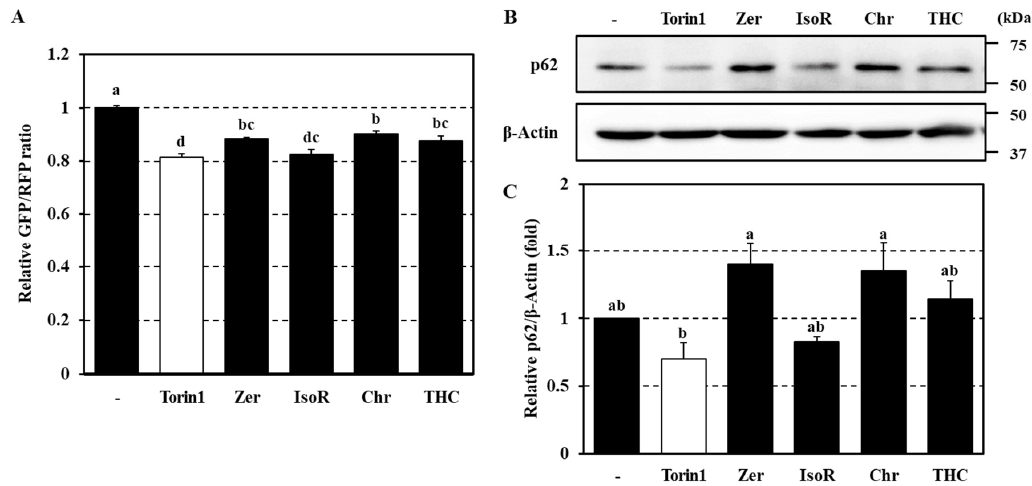
Figure 5. Effects of active phytochemicals on p62 protein expressions in Caco-2 cells. Caco-2 cells were treated with Torin1 (1 µM) or each flavonoid (20 µM) for 4 h. To determine the autophagy flux, intracellular fluorescence intensities were measured using a Cellometer ® Vision instrument to obtain GFP/RFP ratios ( A ). p62 protein level was assessed by western blotting. β -actin was used as an internal control ( B , C ). Data represent the mean ± SEM of triplicate measurements. Different letters indicate significant differences as assessed by the Tukey–Kramer test (p < 0.05) ( C ). Zer, zerumbone; IsoR, isorhamnetin; Chr, chrysoeriol; THC, 2,2 ′ ,4 ′ -trihydroxychalcone.